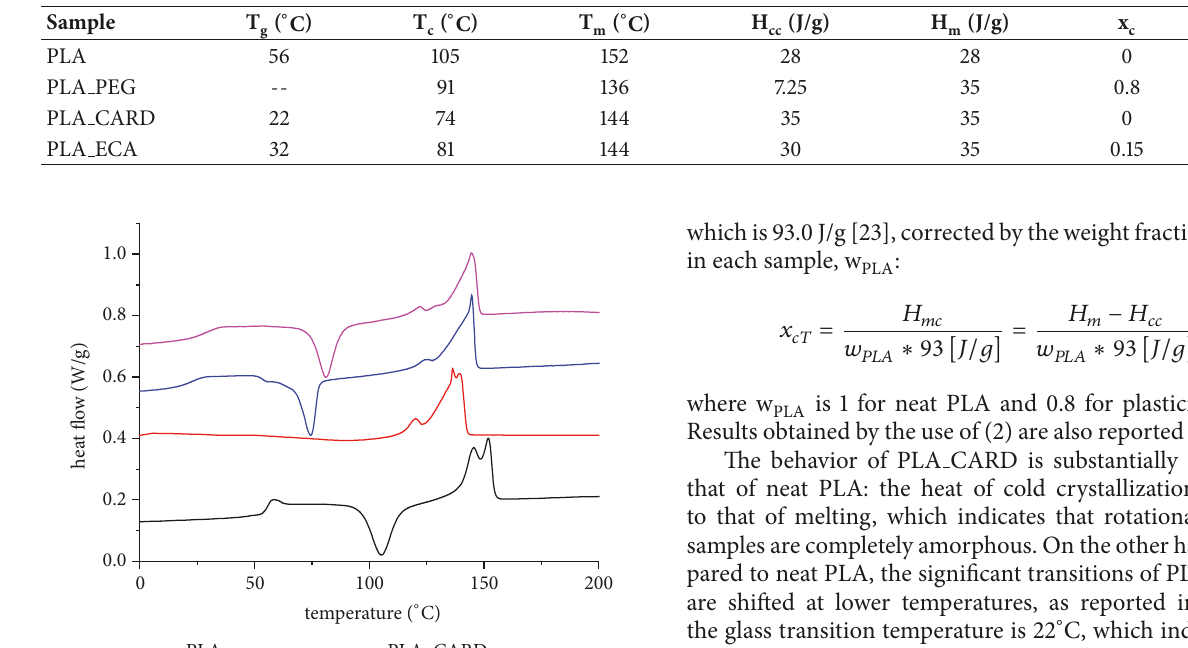
Table 1: Thermal properties of rotational molded PLA.